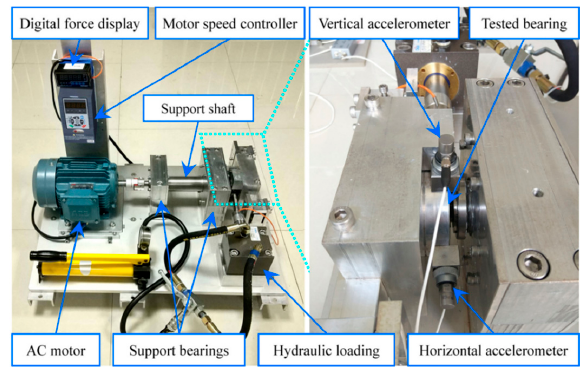
Figure 2. Bearing test stand.